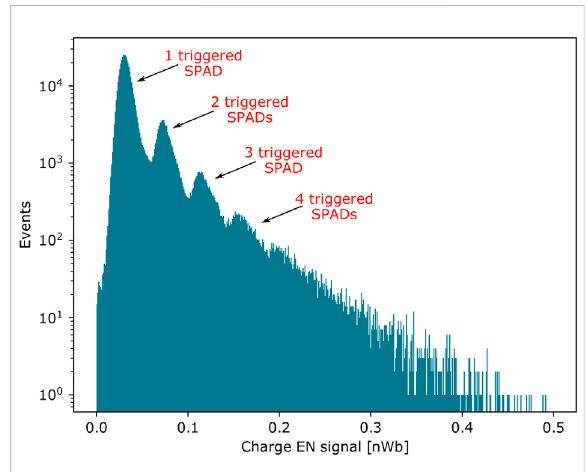
FIGURE 7 Comparison between the integrated charge of low stopping power samples (EJ232, InGaN, and CPB) and only SiPM.